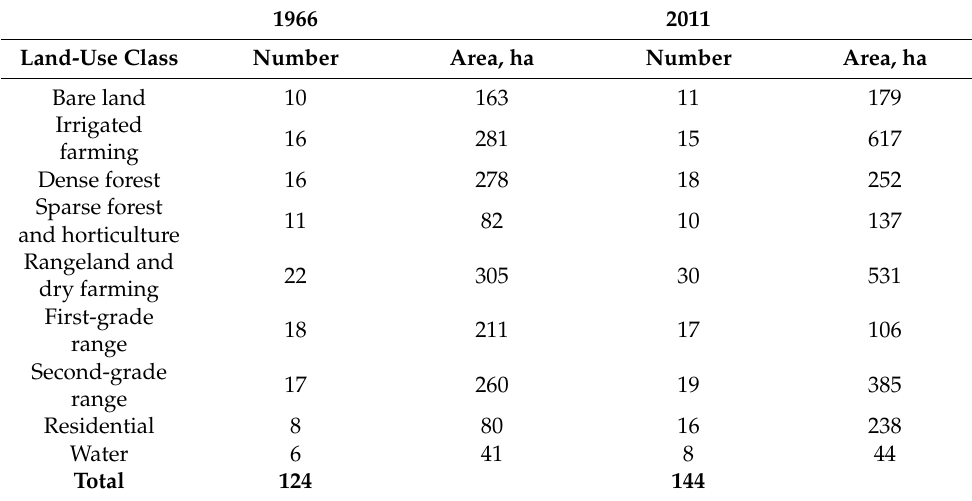
Table 1. Number and total area of ground truth areas used in the classification of satellite images. The classification was made for the whole Haraz River basin (677,393 ha). The results of this study were calculated for a smaller area of 406,000